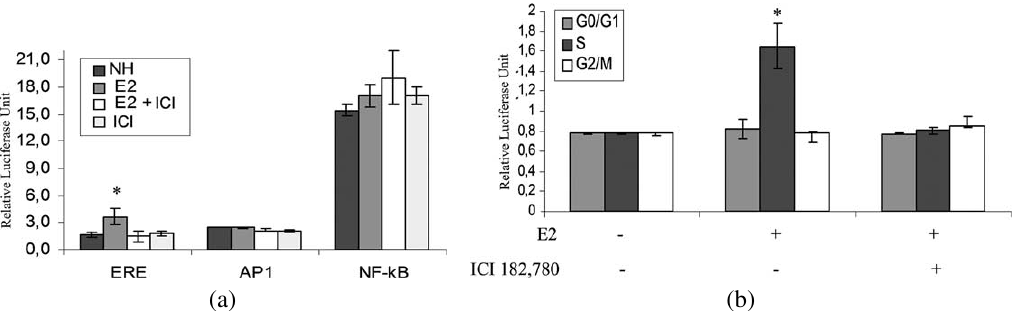
Fig. 5. Transcriptional activity of endogenous ER β in the LNCaP cell line. (a) LNCaP cells transfected with a reporter plasmid that contained a luciferase gene under the transcriptional control of ERE, AP-1 or NF κ B sequences, were either non-treated (NH), treated with E2 (10 nM), ICI 182,780 (1 µM), or both. A significant increase in the luciferase expression was only observed in ERE-LUC transfected cells treated with estradiol. The transcriptional effect was completely abolished by ICI when both chemicals were administered simultaneously. (b) LNCaP cells co-transfected with an ERE-luciferase reporter and a β -galactosidase vector submitted to the same conditions than in (a). Analysis of luciferase activity in cells incubated with Hoescht 33342 and sorted at each cell cycle phase showed ERE transactivation only in S phase. In (a) and (b), β -galactosidase activity was used to normalize the transfection efficiency, ∗ p (cid:2) 0 .